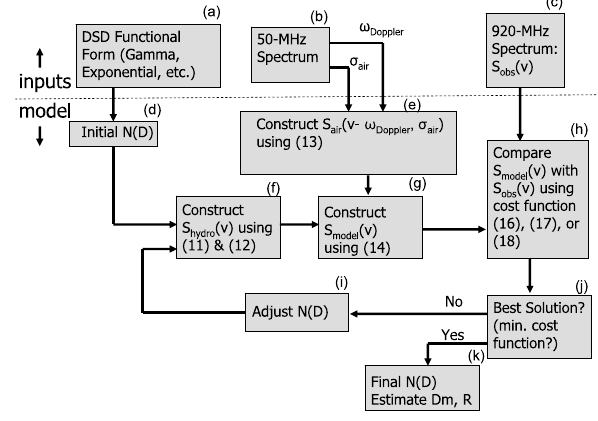
Fig. 1. Convolution method flow